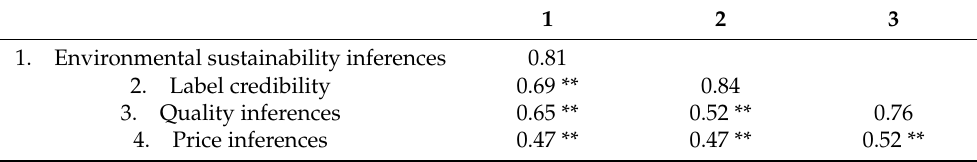
Table 2. Correlation matrix and square roots of AVE.